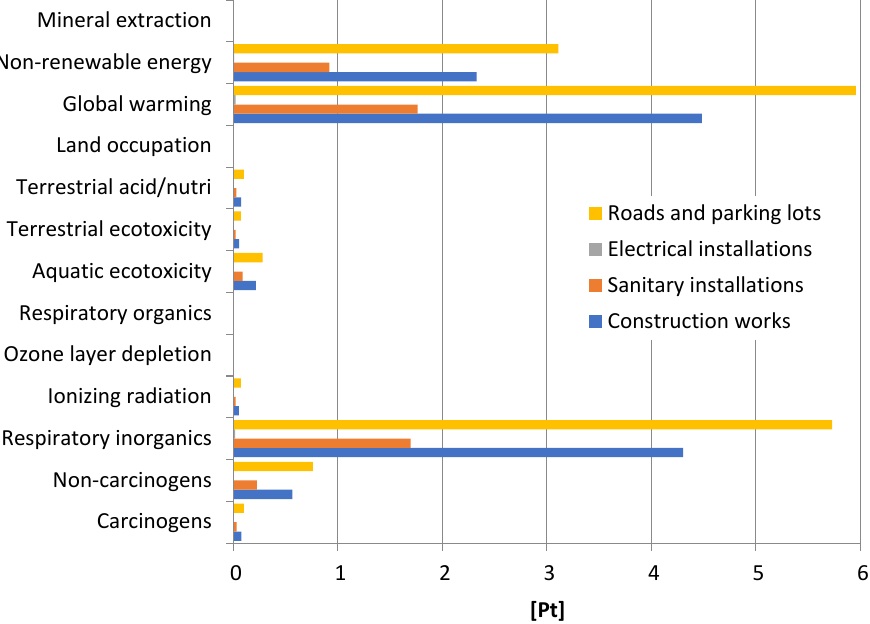
Figure 13. The results of grouping and weighing the environmental consequences occurring at the post-use development stage (in the form of storage) of the research object by thirteen impact categories and groups of installations.